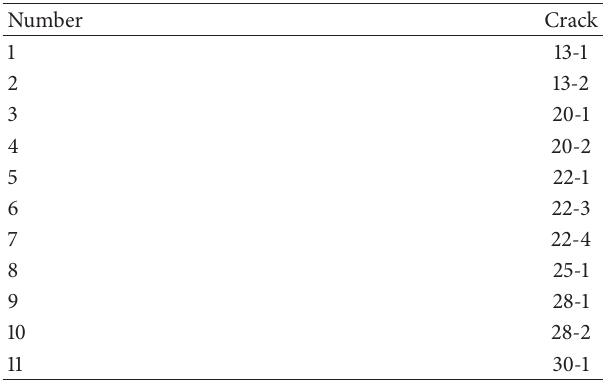
Table 2: Numbers of cracks in the dam.